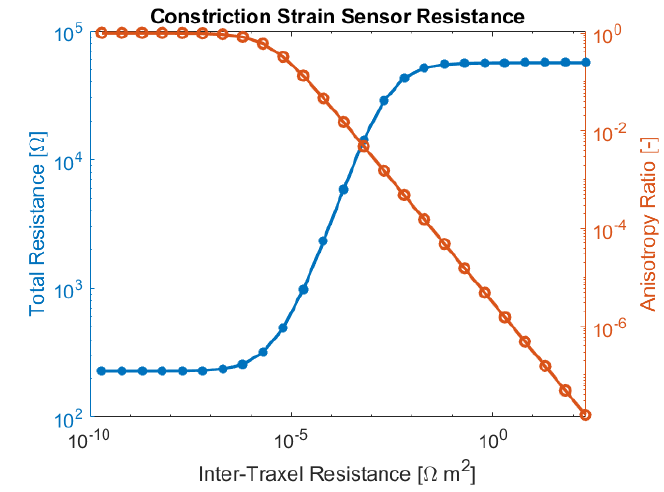
Figure 31. The modelled resistance versus inter-traxel resistance for a constriction-resistive strain sensor, showing a large difference between the lowest and highest resistance. For very low inter-traxel resistance values, the anisotropy ratio is almost 1 and the total resistance stays the same. For very large inter-traxel resistance values, the anisotropy ratio becomes small and, eventually, the total resistance levels out when approaching pure traxel conduction.